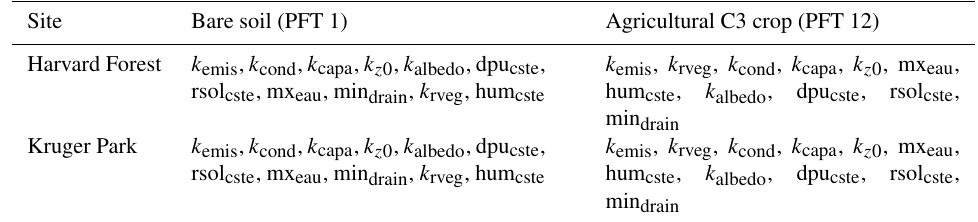
Table 2. Sensitivity analysis results. Parameter hierarchy according to each site and vegetation fraction. The parameters are ranked by decreasing